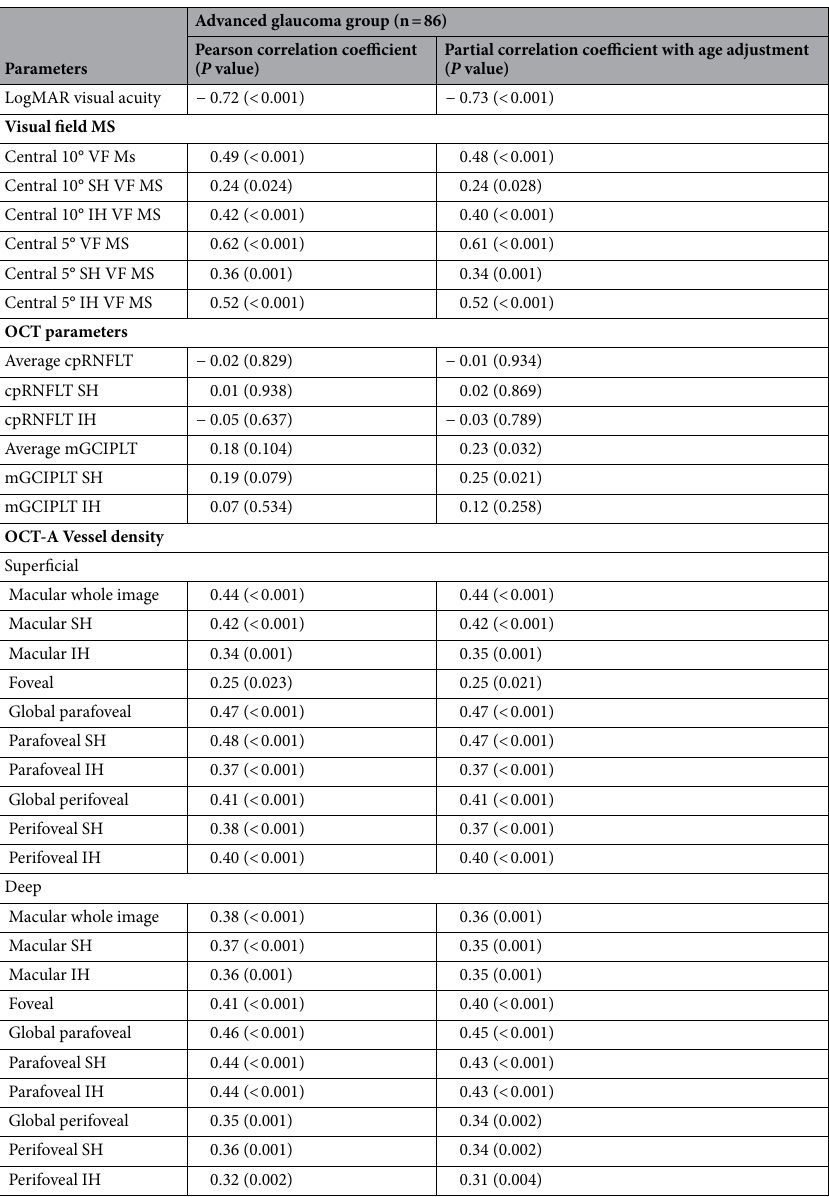
tomography, cpRNFLT, circumpapillary retinal nerve fiber layer thickness; mGCIPLT, macular ganglion cell- inner plexiform layer thickness; SH, superior hemisphere; IH, inferior hemisphere; OCT-A, optical coherence tomography